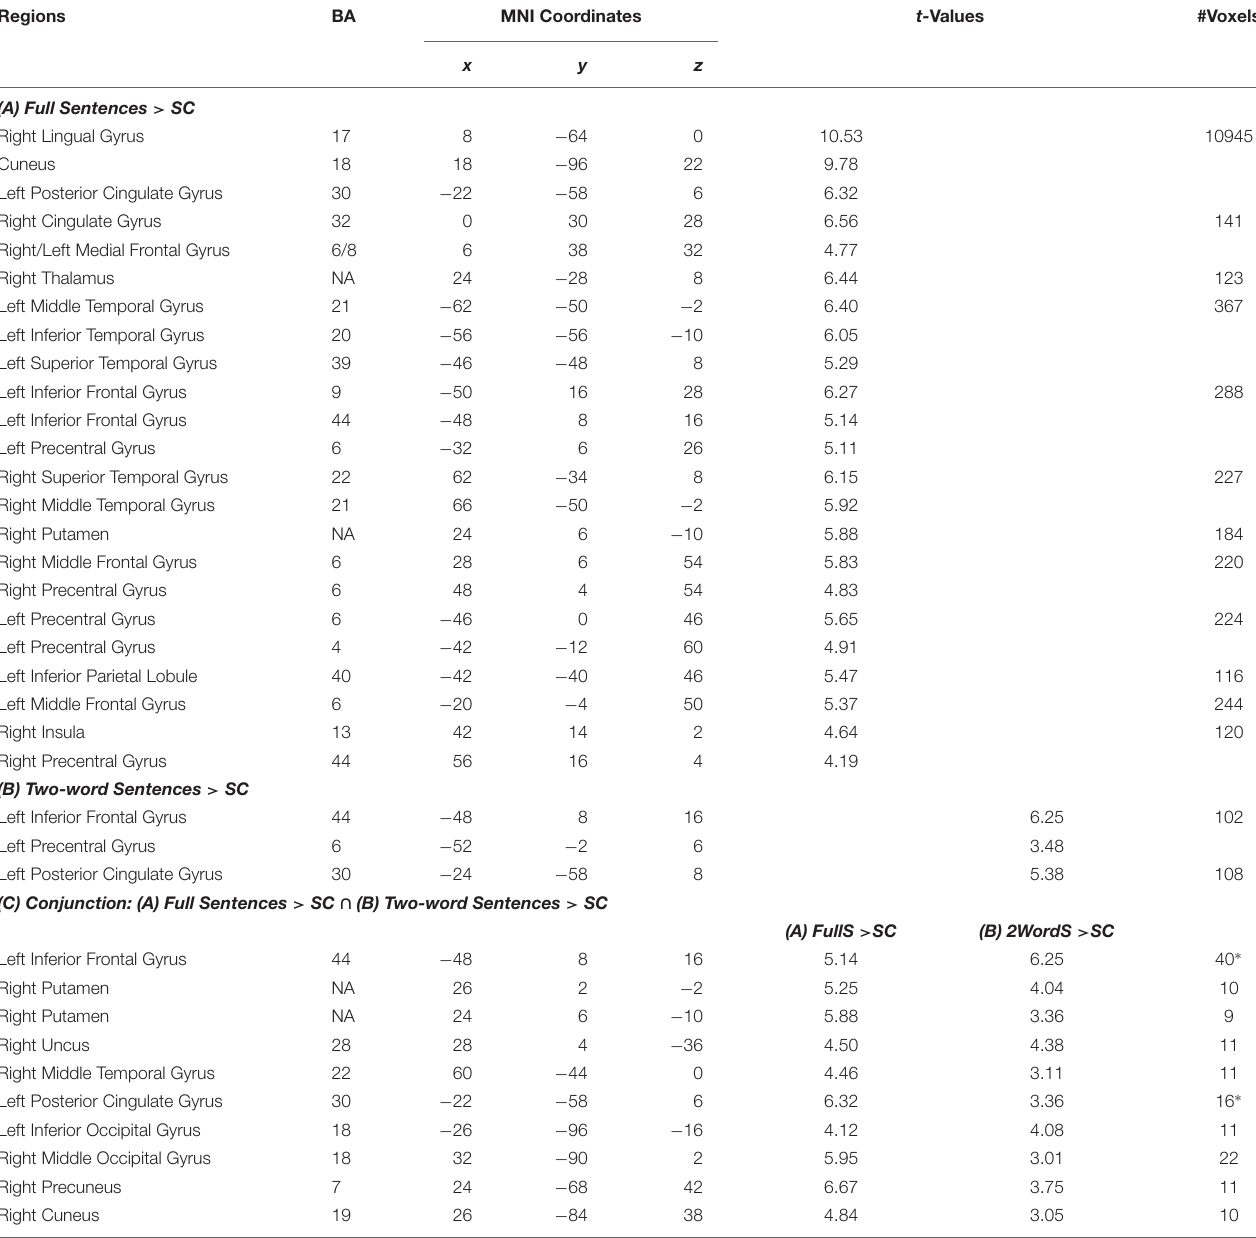
TABLE 1 | Brain regions where activation for small clauses (sc) differs from full sentences and two-word sentences. Regions BA MNI Coordinates t- Values